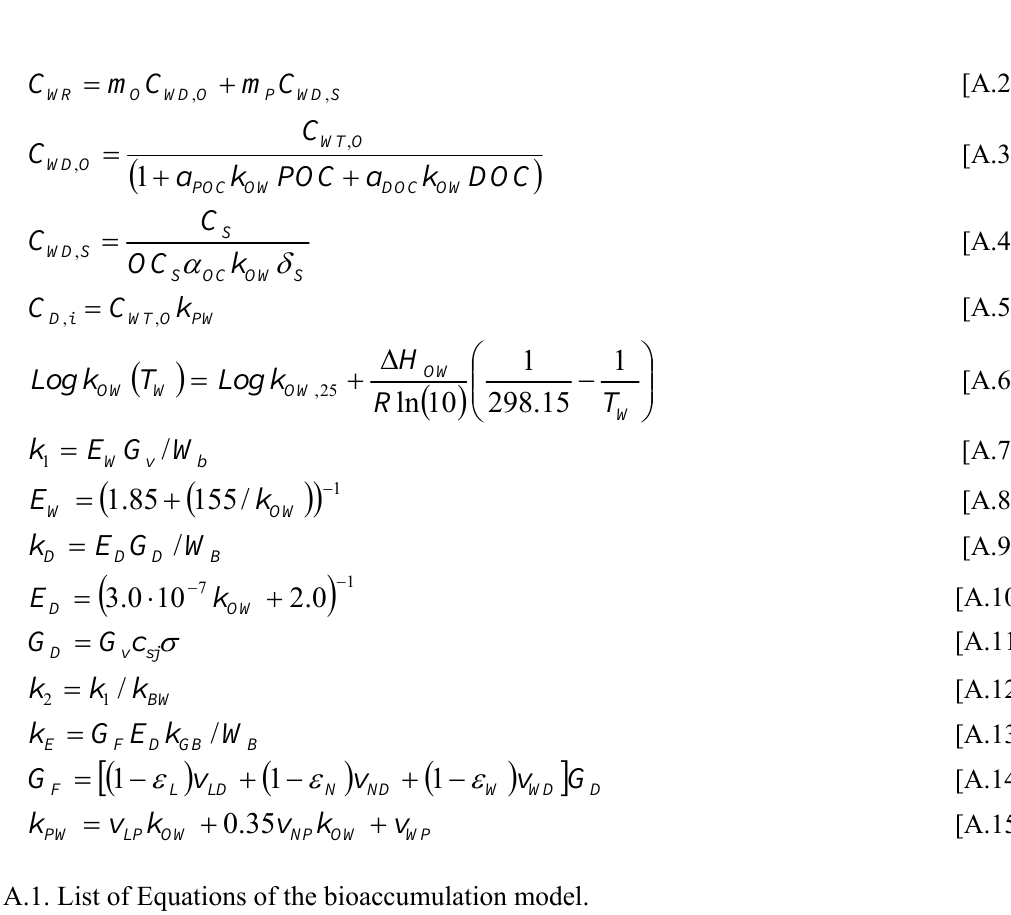
Table A.1. List of Equations of the bioaccumulation model.